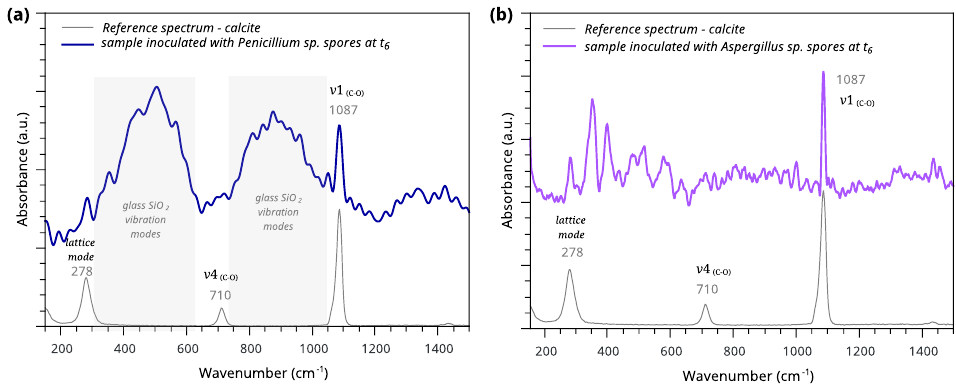
Figure A4. Raman spectra of the identified crystalline products on the glass surfaces inoculated with ( a ) Penicillium chrysogenum spores in Tween, according to literature data [22,23], and ( b ) Aspergillus niger spores in Tween, identified according to literature data [23].